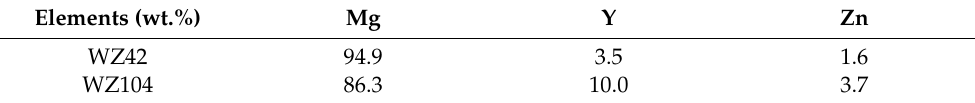
Table 1. Chemical composition of WZ42 and WZ104 alloys, wt.% [16]). Elements